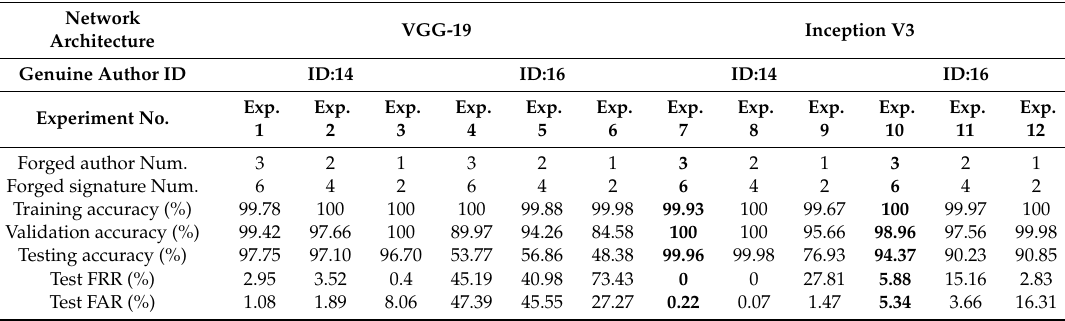
Table 4. The summary of experimental